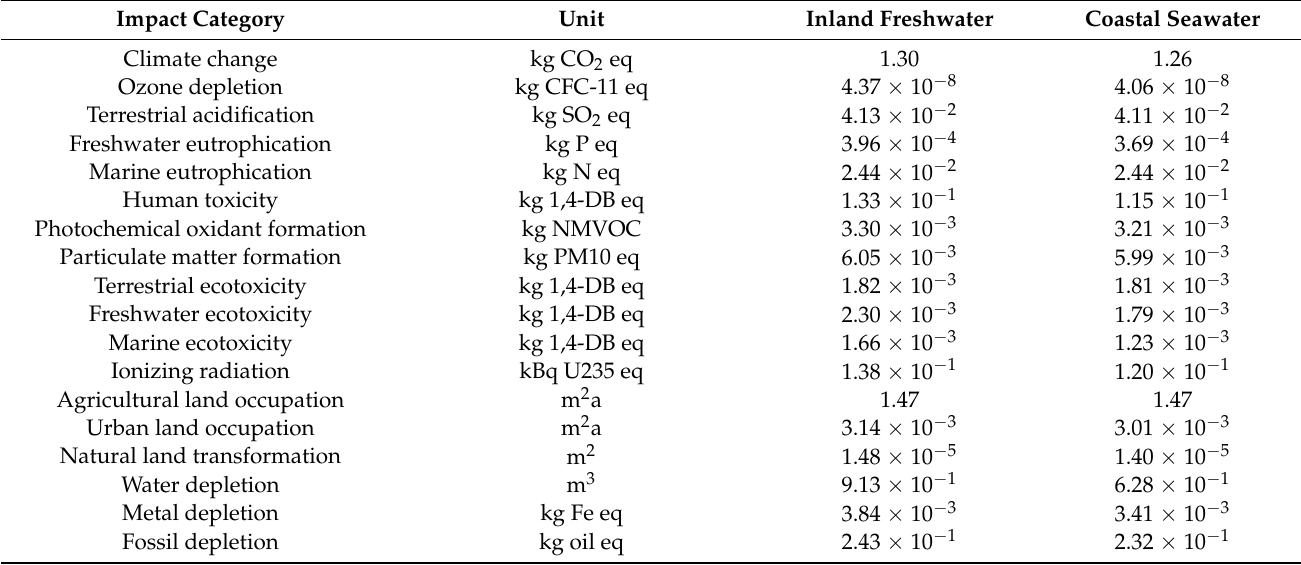
Table 4. Complete life cycle environmental impacts of the two scenarios of bioethanol production.